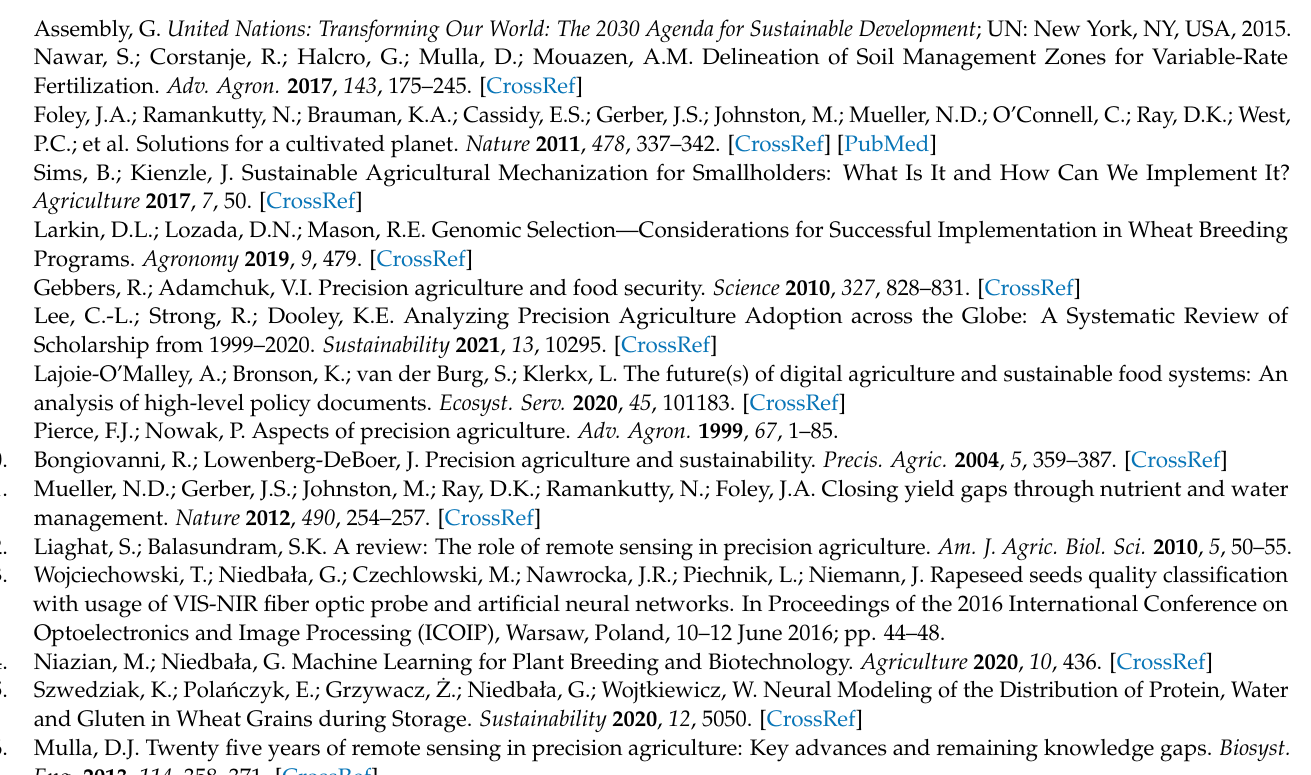
The red-shaded colour follows the description from Table S1, Table S3: The results of statistical tests for model-3. The red-shaded colour follows the description from Table S1, Table S4: The results of statistical tests for model-1 for fertilization at 25 March 2020, Table S5: The results of statistical tests for model-1 for fertilization at 21 April 2020, Table S6: The results of statistical tests for model-3 for fertilization at 25 March 2020, Table S7: The results of statistical tests for model-3 for fertilization at 21 April 2020. The red-shaded colour follows the description from Table